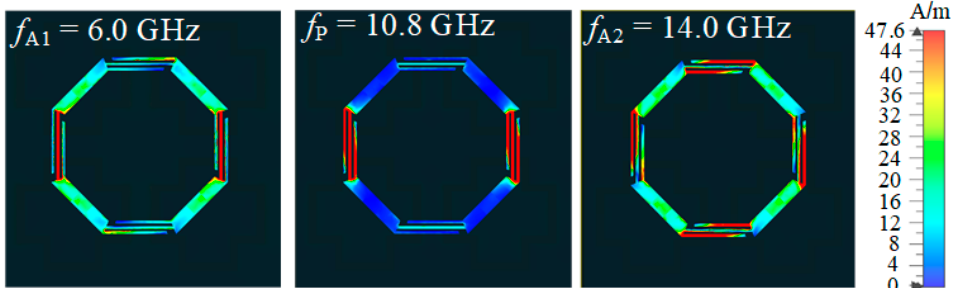
Figure 5. Surface current distributions of the lossy FSS at f A1 , f P , and f A2 .